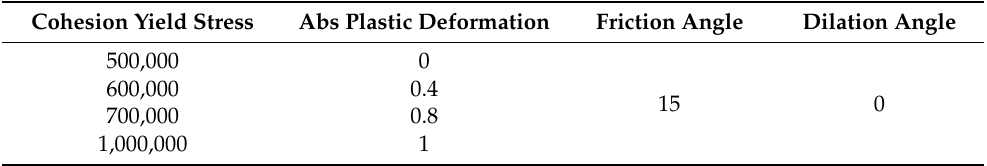
Table 2. MC model input data depending on the value of